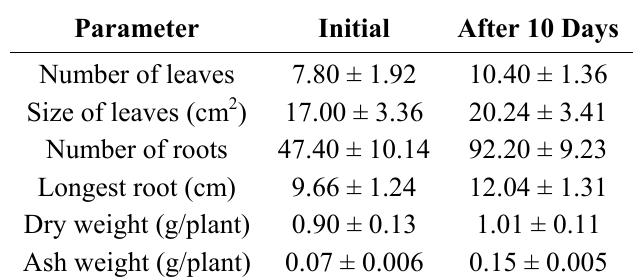
Table 3. Morphological characteristics of the plant at initial setup and after 10 days operation ( n =